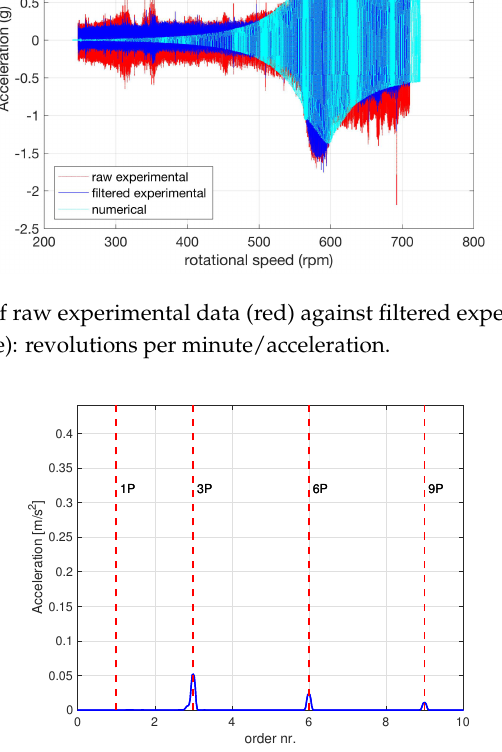
Figure 13. Order spectrum for Y direction tower vibrations from the FAST model: rotor balanced.